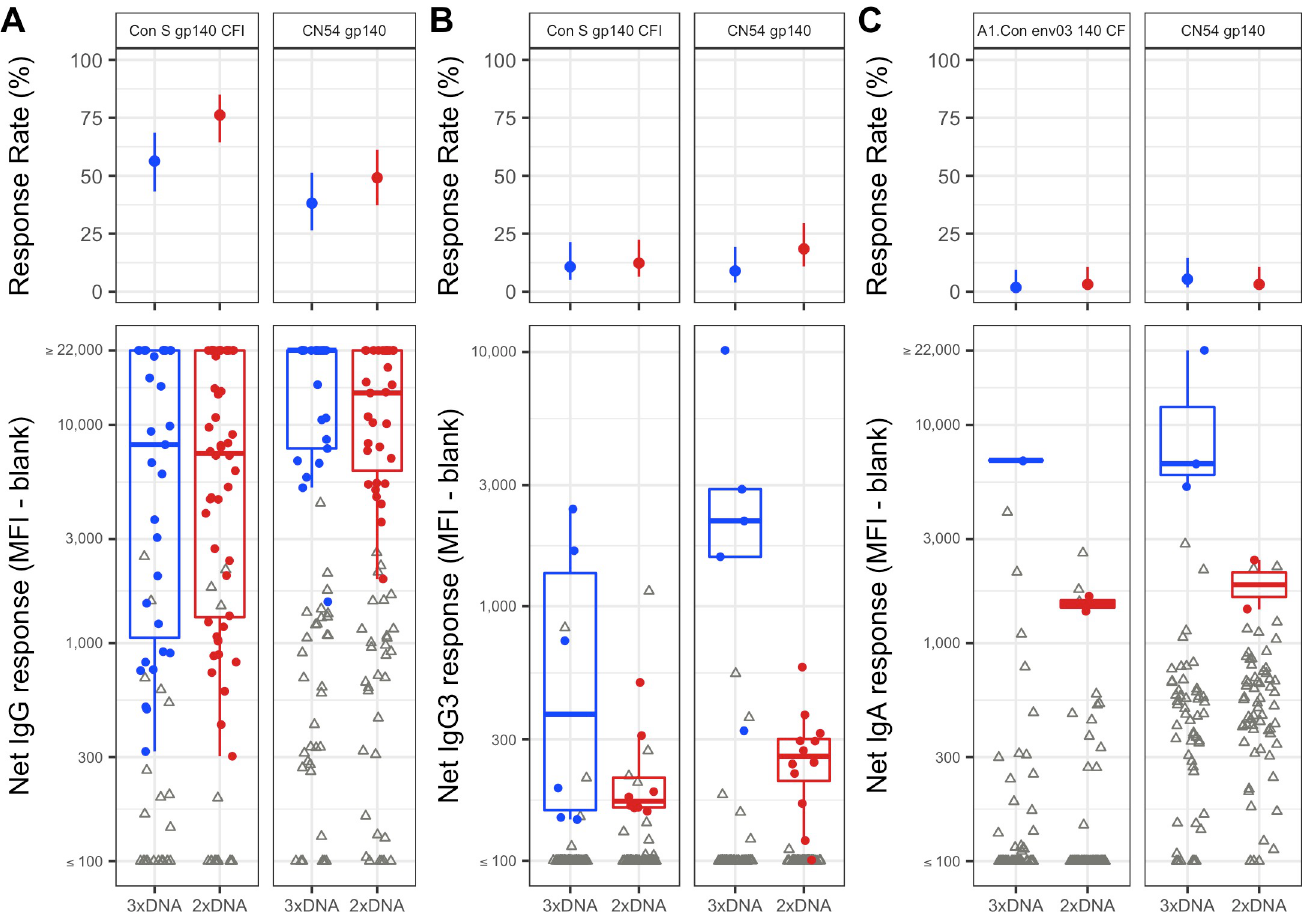
Fig 6. Binding Antibody Responses, EV03/ANRS VAC20 Phase I/II Trial. Response rates with 95% confidence intervals (top) and magnitude of response (bottom) at week 26 with open triangles for non-responders and closed circles for responders. A) IgG for Con S gp140 CFI and CN54 gp140, B) IgG3 for Con S gp140 CFI and CN54 gp140, C) IgA for A1.Con env03 140 CF and CN54 gp140.